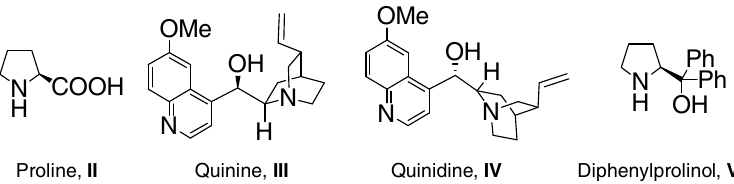
Figure 1. Organocatalysts frequently used in organic synthesis (proline, II ; quinine, III ; quinidine, IV ; and diphenylprolinol, V ).